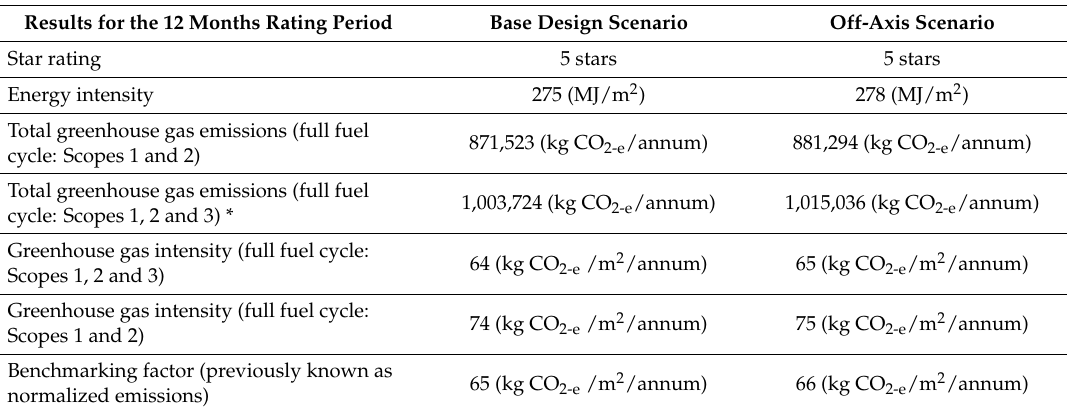
Table 7. Nominated annual performance for each scenario.